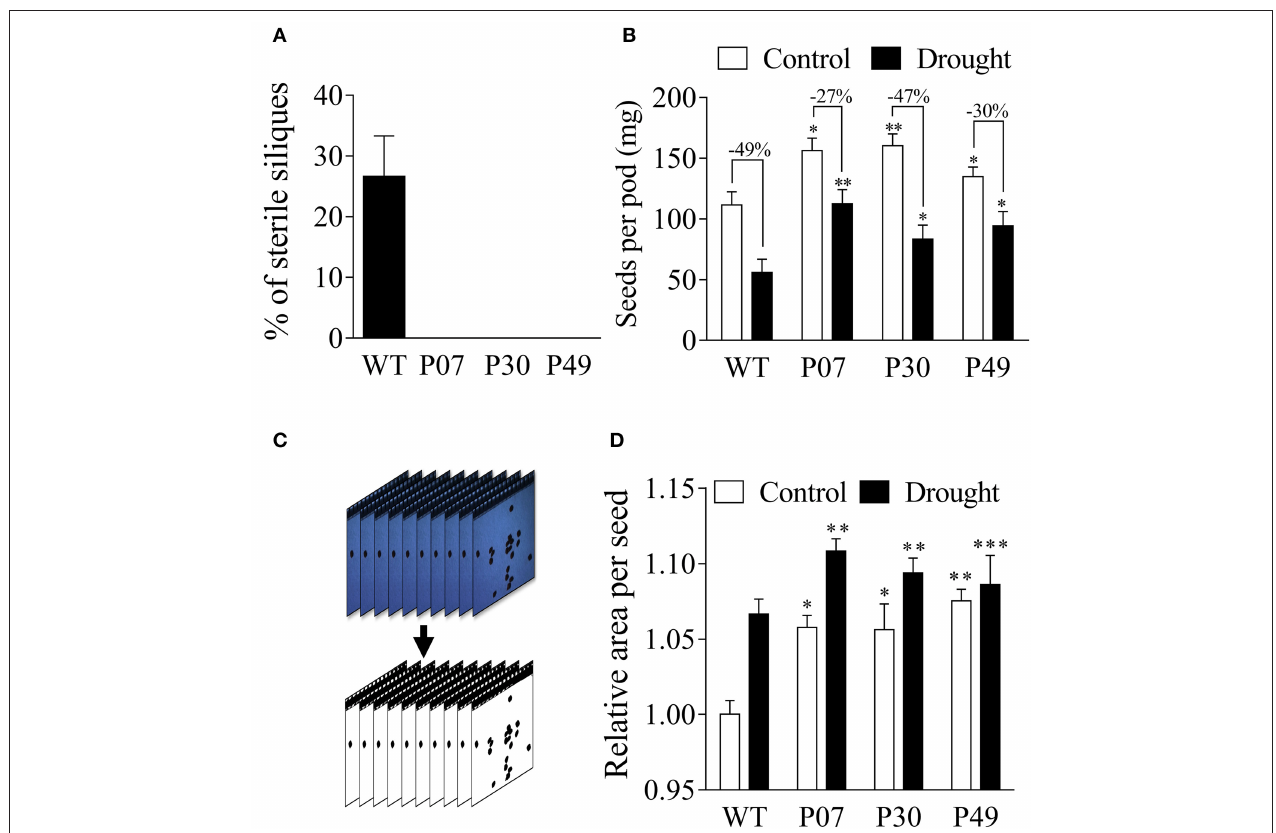
FIGURE 12 | Estimation of the yield of WT and transgenic lines under drought stress. Flower buds (8–12mm) from control and drought-stressed plants (WT and transgenic) were tagged and maintained under normal irrigation until the end of plant life cycle. (A) Transgenic plants did not produce any sterile pods after being subjected to a 15-day drought stress, whereas 25% of WT siliques were sterile. (B) WT plants produced fewer seeds under control conditions and were more affected by drought stress compared to transgenic lines. (C) Seeds were collected from the pods as described in the Materials and Methods, and a field image containing approximately 100 seeds was collected for each pod. We removed the background and adjusted the contrast to measure the individual seed size using ImageJ. (D) Transgenic plants presented larger seeds under control conditions than did WT plants. The seed size increased equally by approximately 5% in all genotypes after drought treatment. Bars represent the means of 25 pods and 2,500 seeds ± SD for seed mass and area, respectively. Bars with *, **, and *** differ significantly from the WT ( P < 0.1, P < 0.05, and P < 0.01,